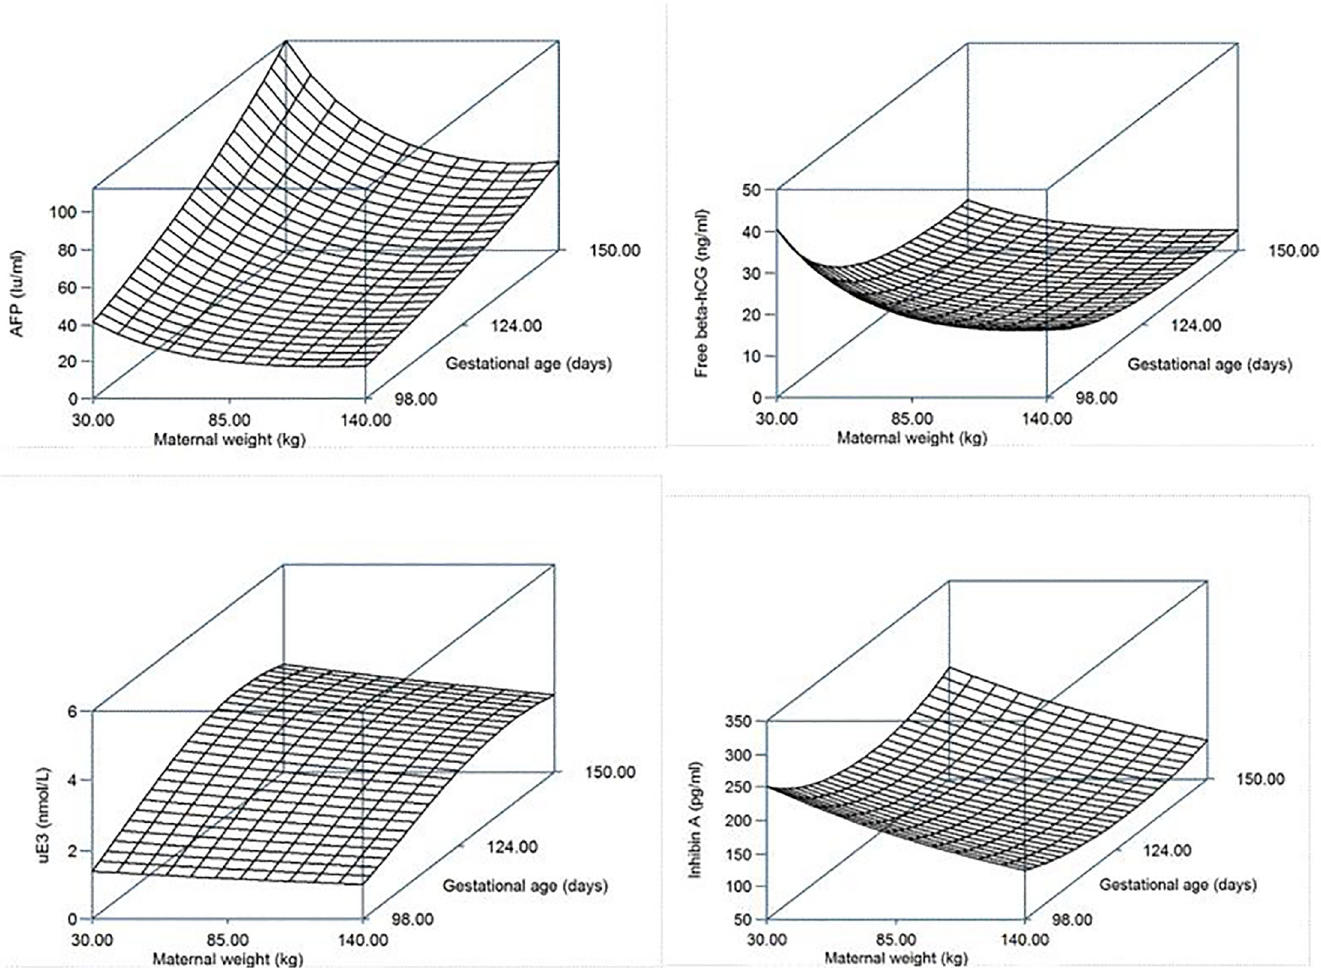
Fig 3. Surface models of predicted median MoMs of maternal serum quadruple levels constructed from the regression equations adjusted for gestational age (days) and maternal weight (kg) of Thai ethnicity pregnant women.